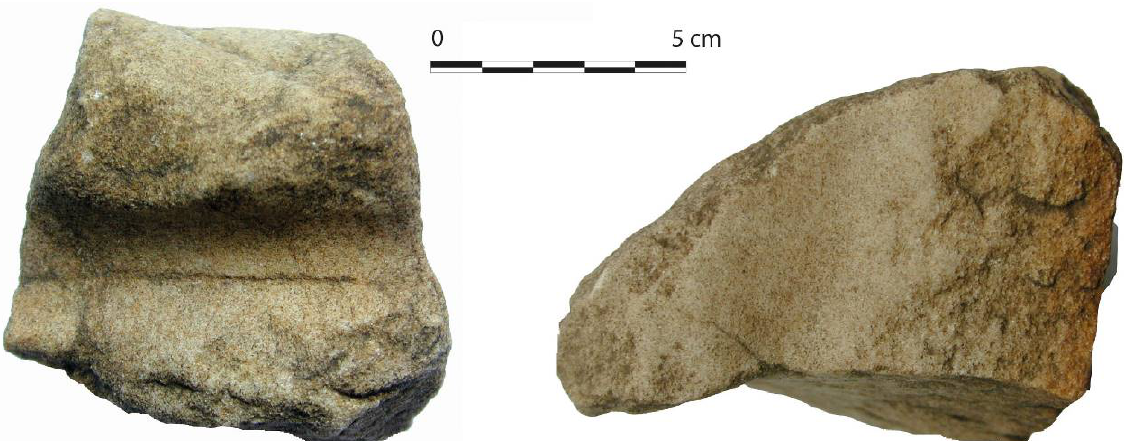
Figure 4. Examples of grooved abraders in Menneville (Aisne Valley) made on flakes from quern shaping which were opportunistically chosen as